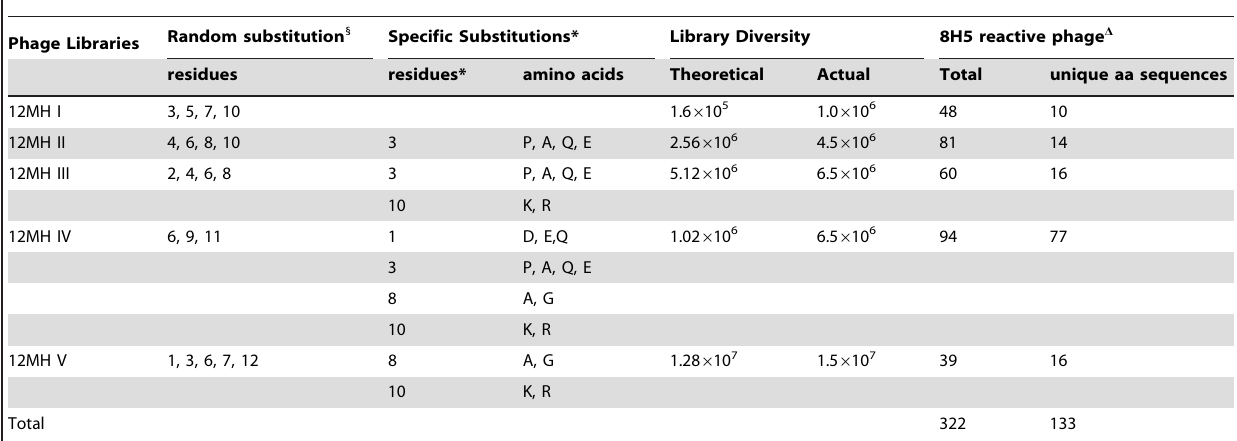
Table 1. Generation of p125 phage